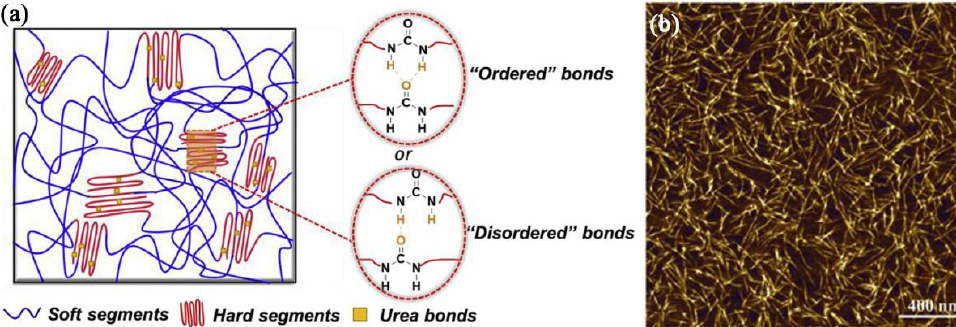
Figure 1. Structure of segmented polyurea: ( a ) Simplified structure; ( b ) AFM tapping mode phase images of polyurea. Reproduced with permission from ref. [2].